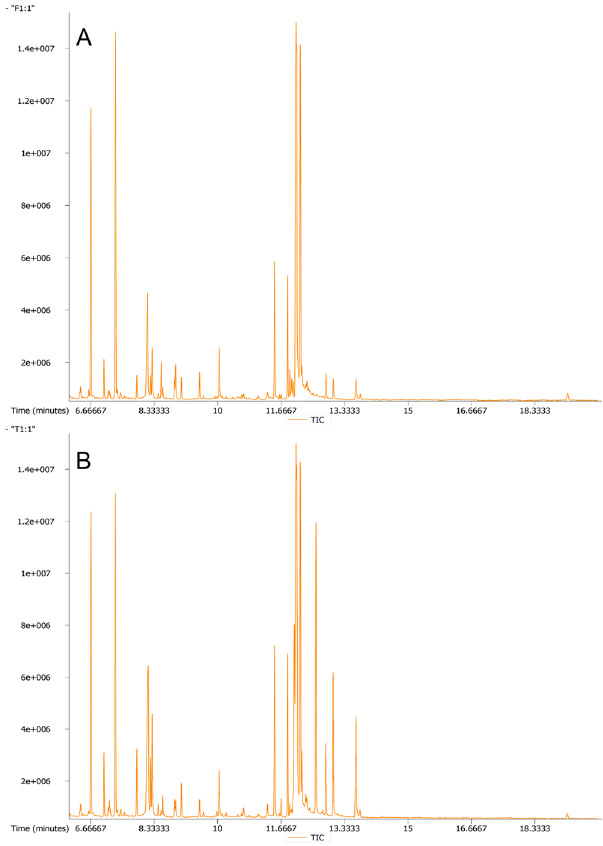
Figure 2. Typical TICs of metabolic profiles of early-stage NSCLC patients ( A ) and HC ( B ) based on GC-TOF/ MS